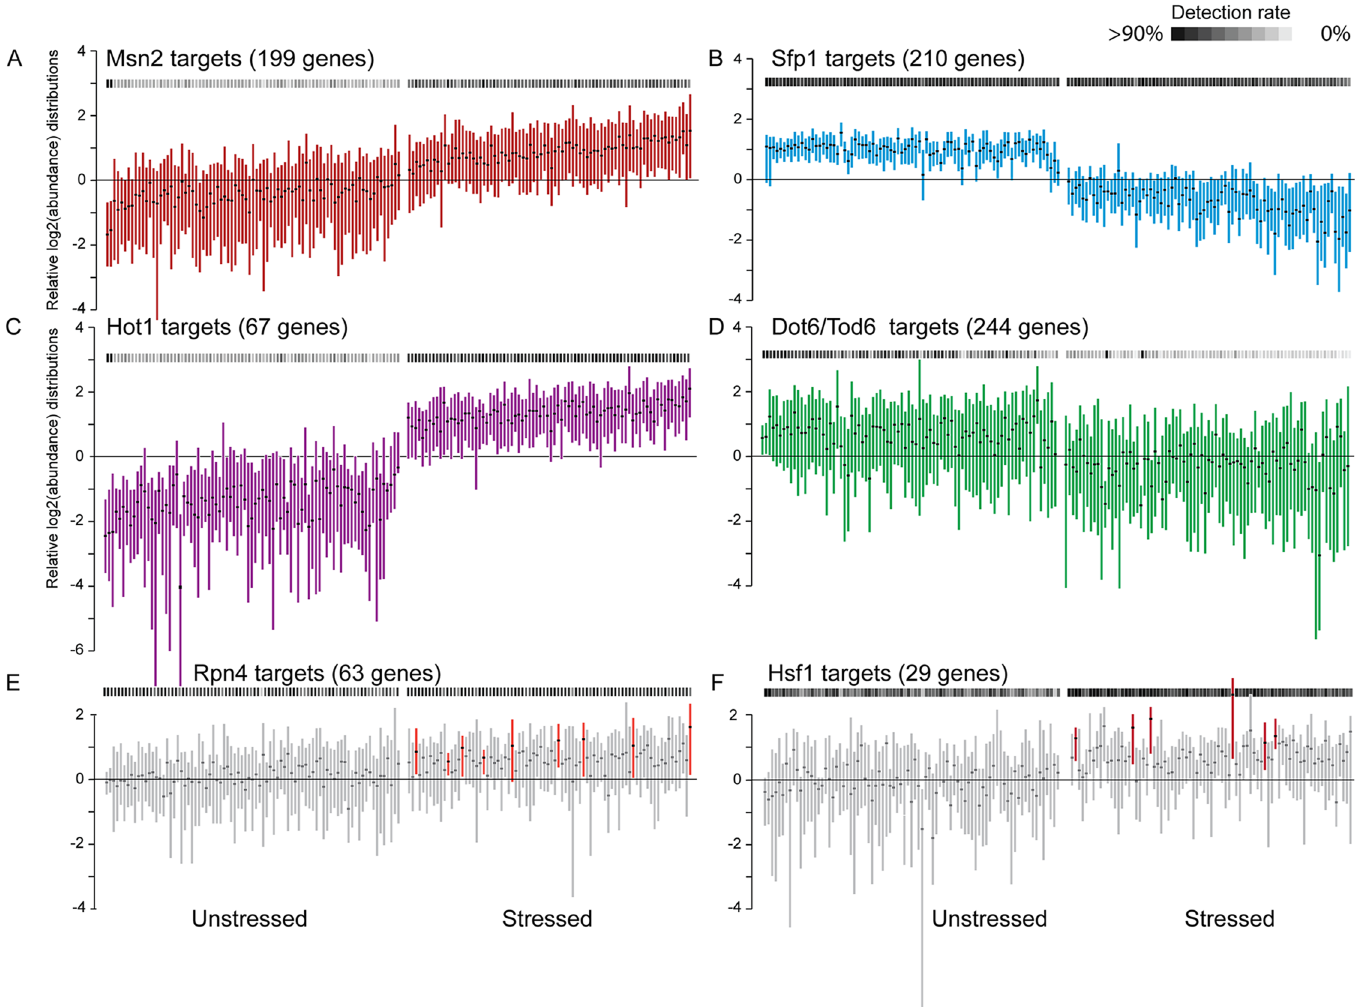
Fig 6. Regulatory variation across single cells. Distribution(without whiskers) of mean-centered log 2 (read count) values for indicatedTF targets in single cells, organizedas in Fig 1C. The number of targets for each TF is shown in parentheses. Grey-scale heat map (horizontal boxes) represents the detection rate, accordingto the key. (A-D) Targets of TFs that were differentially expressedin a large fraction of cells (see S6 Table).(E-F) Cells for which targets of Rpn4 (E) or Hsf1 (F) were significantly elevated (FDR < 0.053) comparedto all other stressed cells are colored. TF, transcription factor.